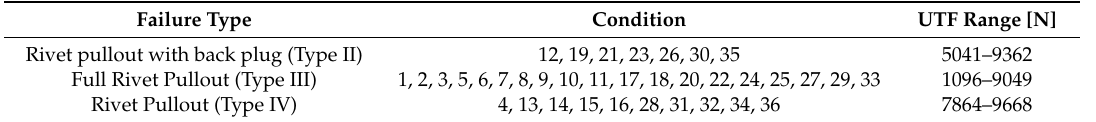
Table 6. Types of fracture obtained for the tested joints.